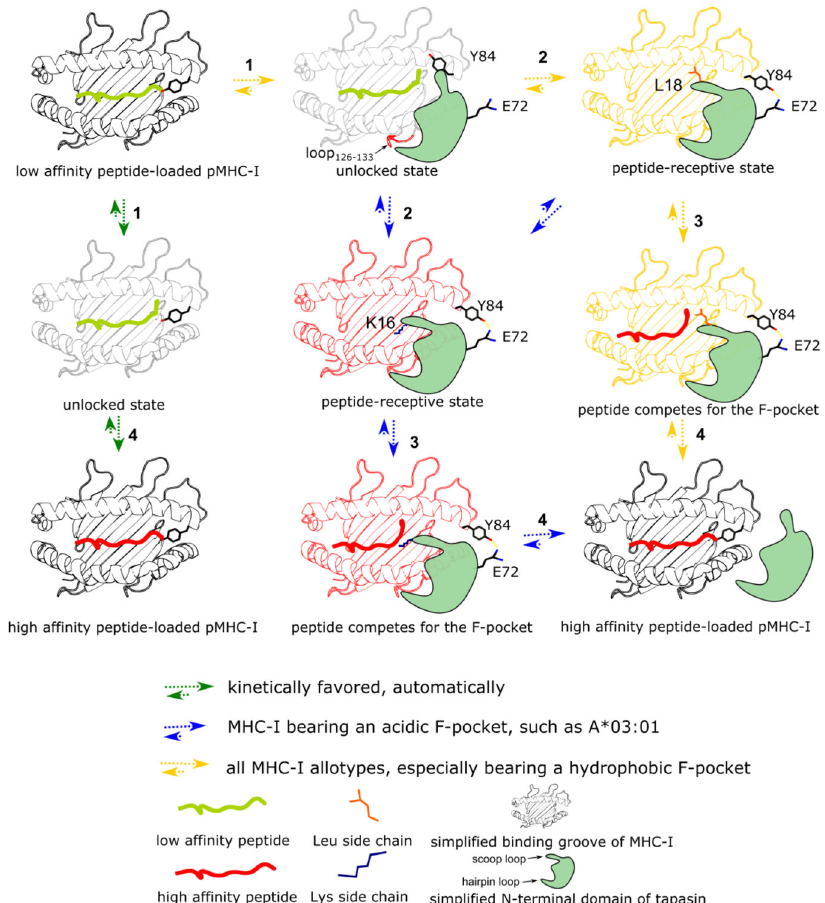
Fig. 6 The proposed mechanism of tapasin-mediated peptide exchange. Step 1: pMHC-I molecules sample conformations, which determine peptide binding and tapapsin binding. Tapasin recognizes a certain state of pMHC-I by approaching pMHC-I from the α 2 -helix side of the pMHC-I. Interaction between its loop 187-196 with the loop 126-133 of heavy chain provides initial binding which alters the dynamics of the peptide binding groove and subsequently together with the interaction between its E72 in strands β 3 and Y84 of the heavy chain promote the C-terminus of peptide to adopt loose binding in the F- pocket accompanied. Now pMHC-I switches to the unlocked state. MHC-I charged with very low af fi nity peptide can switch to peptide unlocked state automatically by the motion of the bound peptide adopting loose binding state. Step 2: The scoop loop 11-20 interacts with the F-pocket region and stabilize the F-pocket with side chain of L18. Now pMHC-I switches to the peptide receptive state. For allotypes bearing a negatively charged F-pocket, tapasin can also use the residue K16 in the scoop loop 11-20 to stabilize the charged F-pocket, which increases the ef fi ciency of tapasin-mediated peptide exchange. Step 3: The upcoming peptide competes for the F-pocket until the af fi nity is high enough to replace the side chain. Step 4: Once the high-af fi nity peptide binds, tapasin is released from the